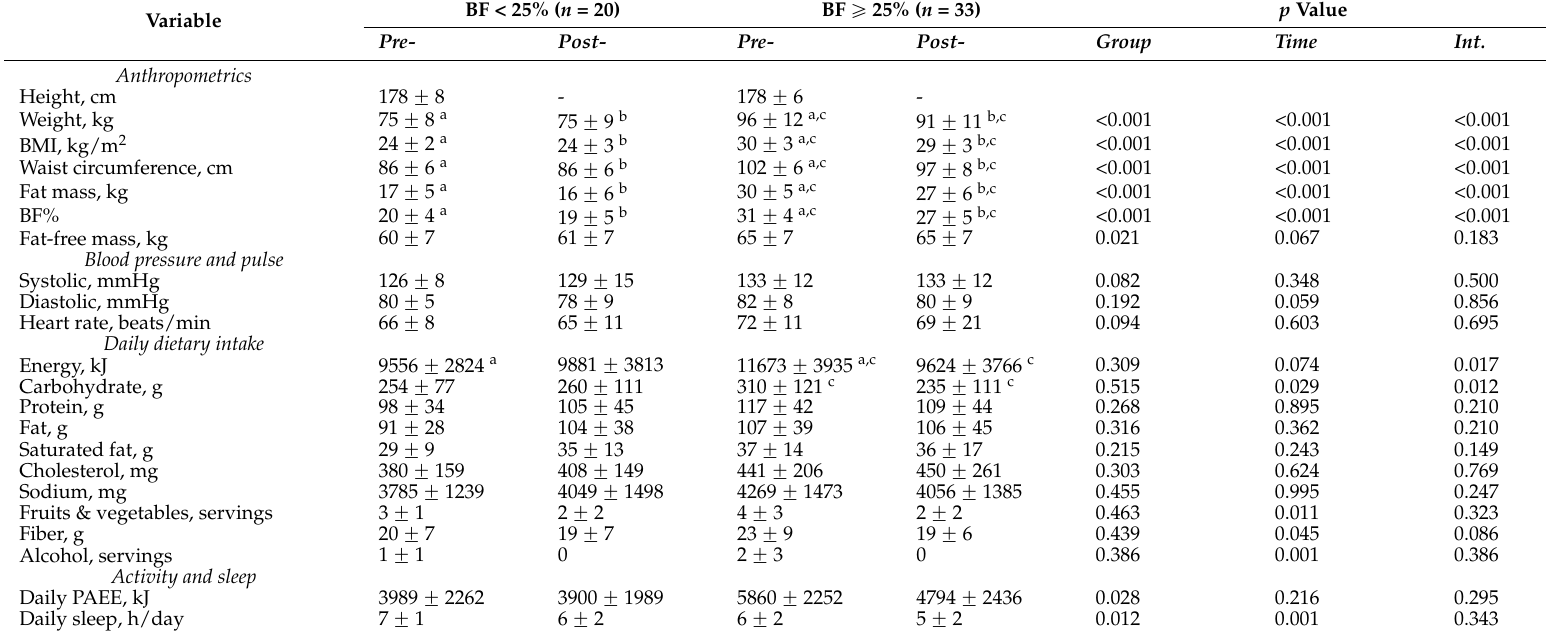
Table 2. Anthropometrics, clinical and health related characteristics in non-obese and obese submariners before and after a 3-month